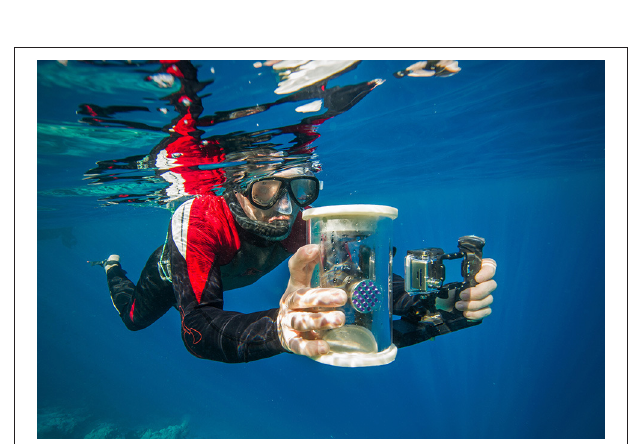
FIGURE 13 | Customised tools for coral research. 3D printed UV torch container and camera stabiliser used for field coral